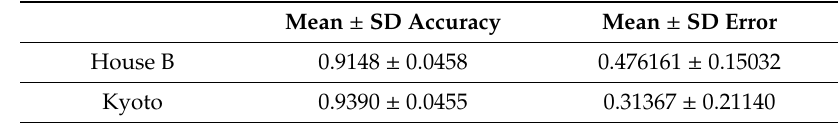
Table 7. 10-fold Cross-validation Result.